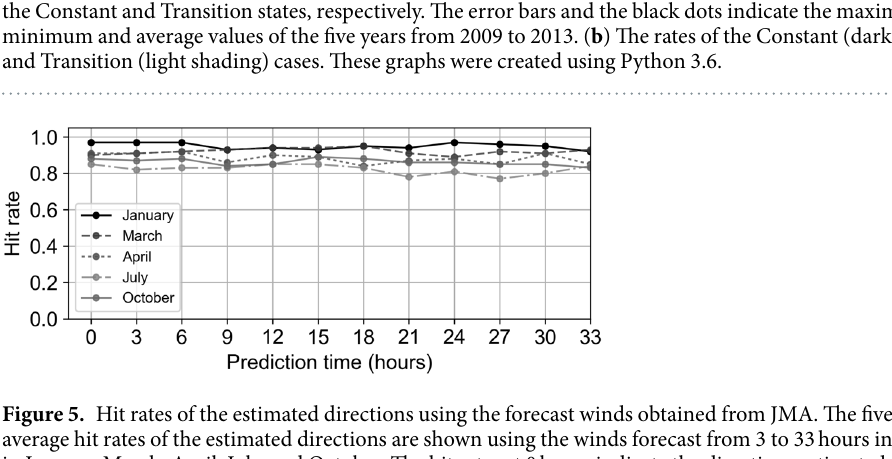
important role in transporting radioactive materials more than 200 km from emission sources 21 . Therefore, the near-surface winds may be the most important factor in the prediction of dispersion directions. The hit rates in the Constant cases are higher than those in the Transition cases. Large-scale weather systems are found in the composite wind fields associated with the Constant cases (see Supplementary Fig. S5). The wind fields are thought to be well represented by the many similar situations in which these common weather sys-